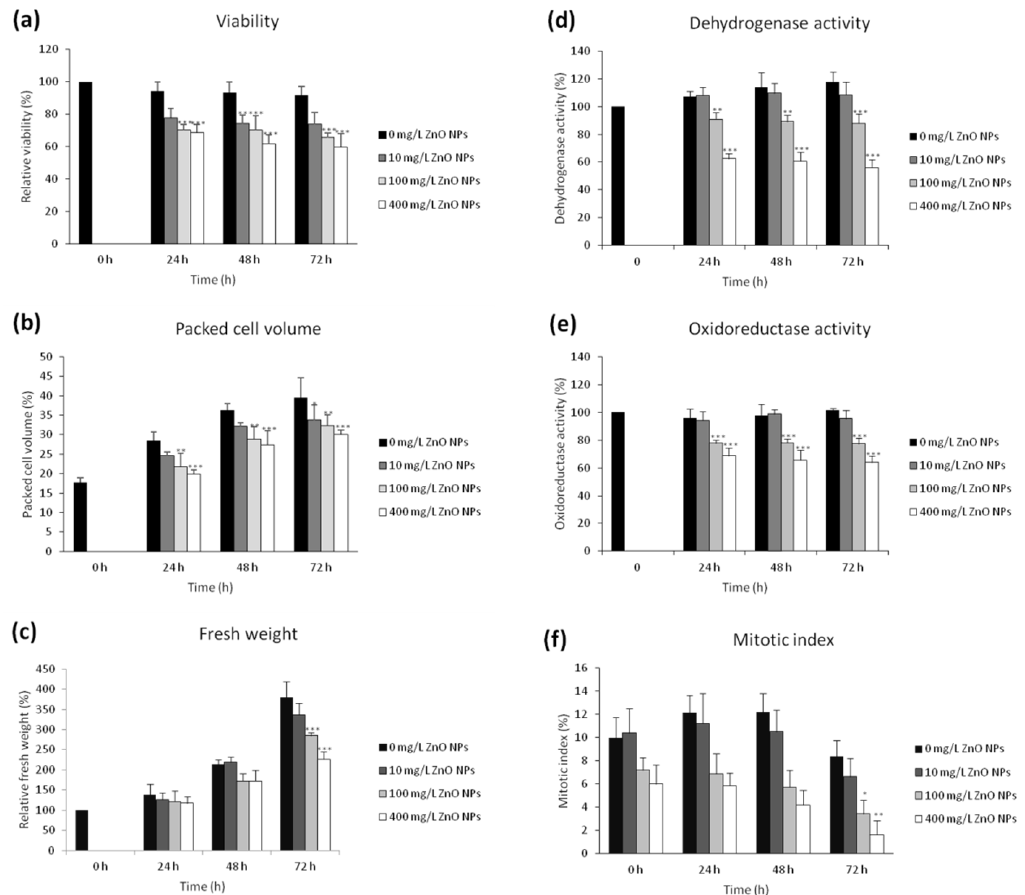
Figure 1. The e ff ect of ZnO NPs on viability ( a ), packed cell volume ( b ), fresh weight ( c ), dehydrogenase activity ( d ), oxidoreductase activity ( e ) and mitotic index ( f ) of tobacco BY-2 cells. Cells were harvested at strictly defined time intervals (0, 24, 48, and 72 h) after the treatment. Each point represents the mean of three independent experiments. * indicates a significant di ff erence between BY-2 cells treated with ZnO NPs and the corresponding control (untreated) BY-2 cells at p < 0.05, ** indicates a significant di ff erence between the BY-2 cells treated with ZnO NPs and the corresponding control (untreated) BY-2 cells at p < 0.01, *** indicates a significant di ff erence between the BY-2 cells treated with ZnO NPs and the corresponding control (untreated) BY-2 cells at p < 0.001. Bars represent standard deviations. To determine the e ff ect of ZnO NPs on BY-2 cells growth parameters, PCV, FW, and mitotic index were probed. ZnO NPs in concentrations 100 mg / L and 400 mg / L had a significant ( p < 0.01 or p < 0.001) negative impact on the growth measured as PCV. PCV after 24 h for the control, 100 mg / L and 400 mg / L were 28.4 ± 2.3%, 21.8 ± 3.4%, and 19.9 ± 1.0%, respectively. At the end of the experiment (72